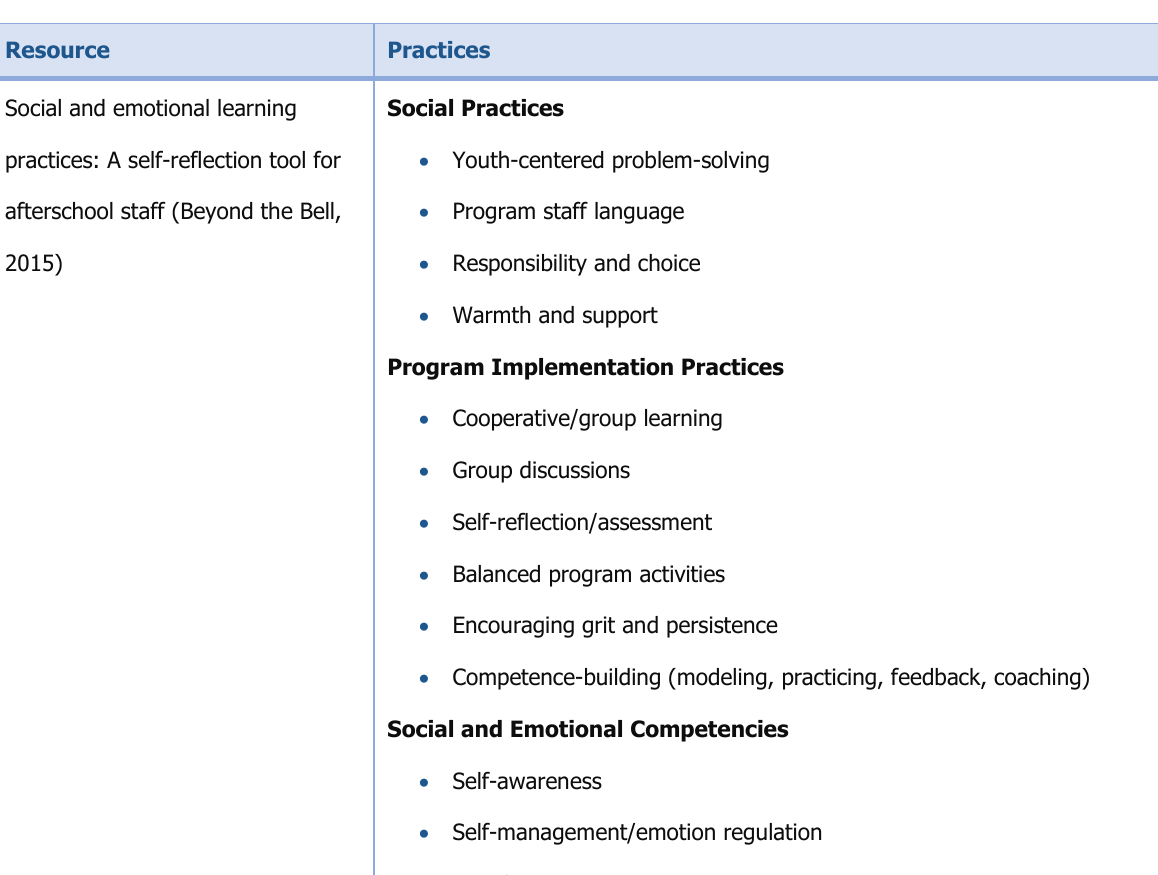
Table 1. Practices and Recommendations From Resources Selected for Review and